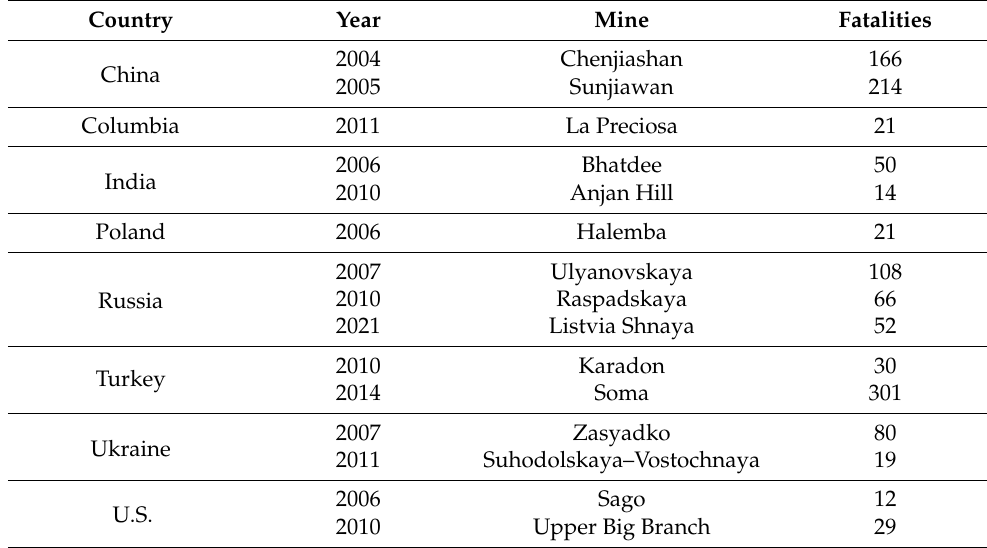
Table 1. Notable gas explosions of major coal-producing countries after 2000